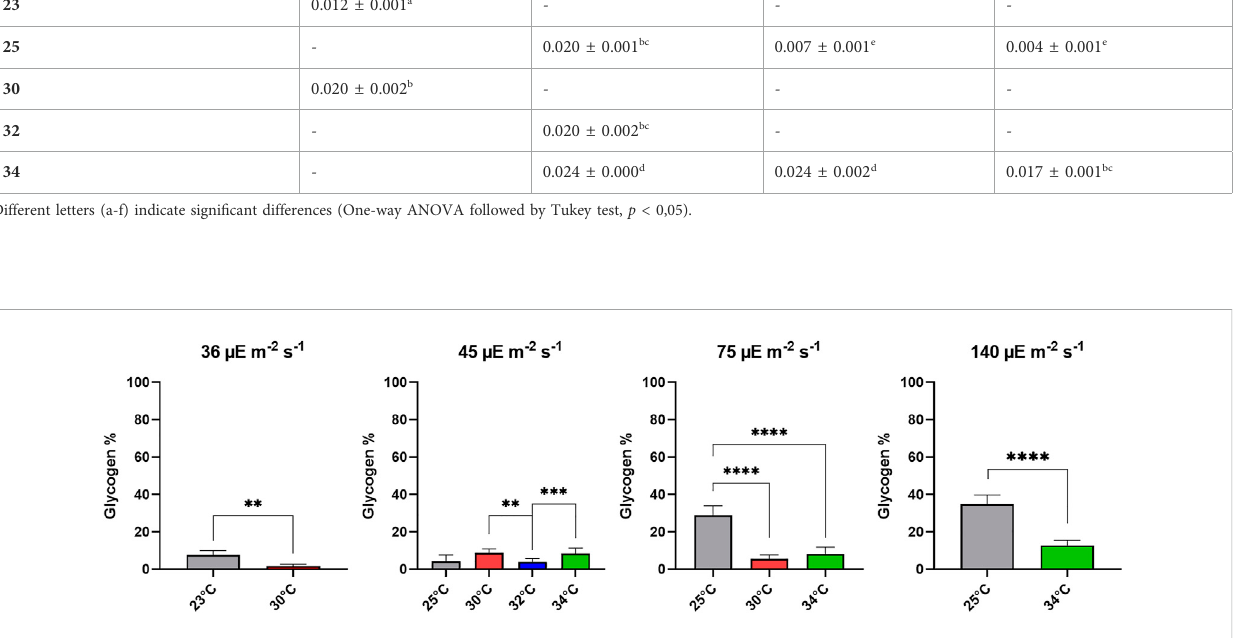
FIGURE 5 Glycogen content (wt%) of Limnospira indica cultures under different light intensities and temperatures, the values are shown as mean ± SD, statistics using one-way ANOVA followed by Tukey test, * = p < 0,05; ** = p < 0,01; *** = p < 0.001 and **** = p <